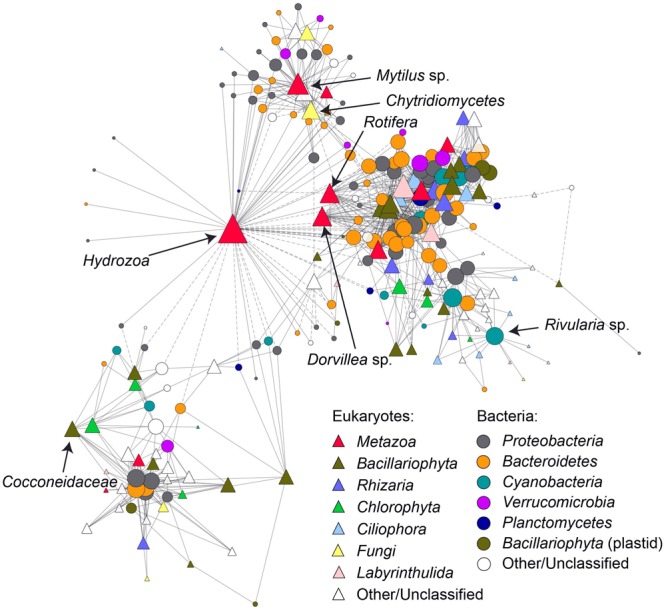
Co-occurrence of bacterial and eukaryotic rRNA gene sequence variants presented as a network. Solid lines (network edges) indicate significant positive Pearson correlations (r > 0.8, p < 0.01) between bacterial (circles) and eukaryotic (triangles) rRNA gene sequence variants (i.e., taxa, network nodes) while dashed lines indicate significant negative correlations (r > –0.8, p < 0.01). Nodes are sized according to the number of correlating neighbors (degree) and color-coded according to taxonomic affiliation. Selected prominent nodes (same as in Figure 4) are further labeled with more detailed taxonomic classifications.